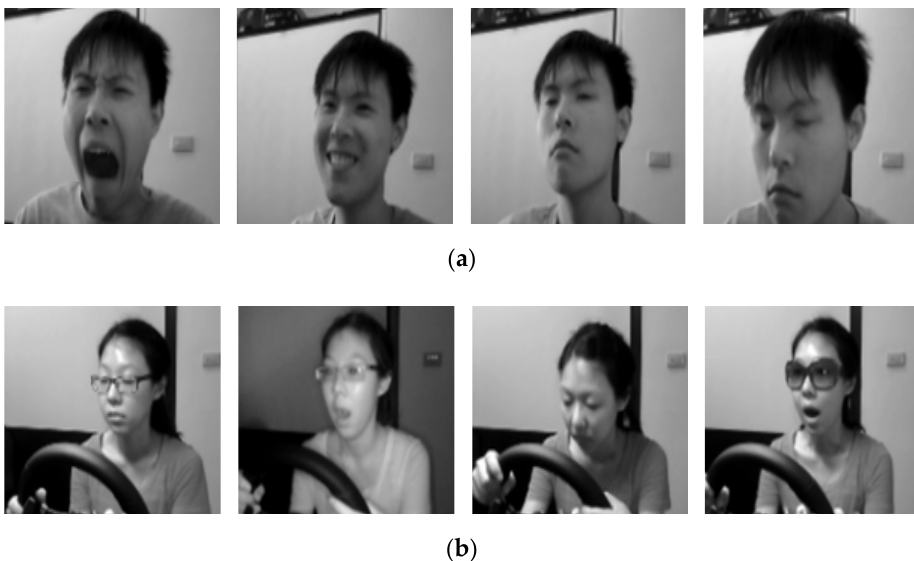
Figure 6. Example frames of the National Tsing Hua University drowsy driver detection (NTHU-DDD) video dataset with different situations. ( a ) Examples of changes in different facial states in the same scenario; ( b ) Examples of state changes under different scenarios.